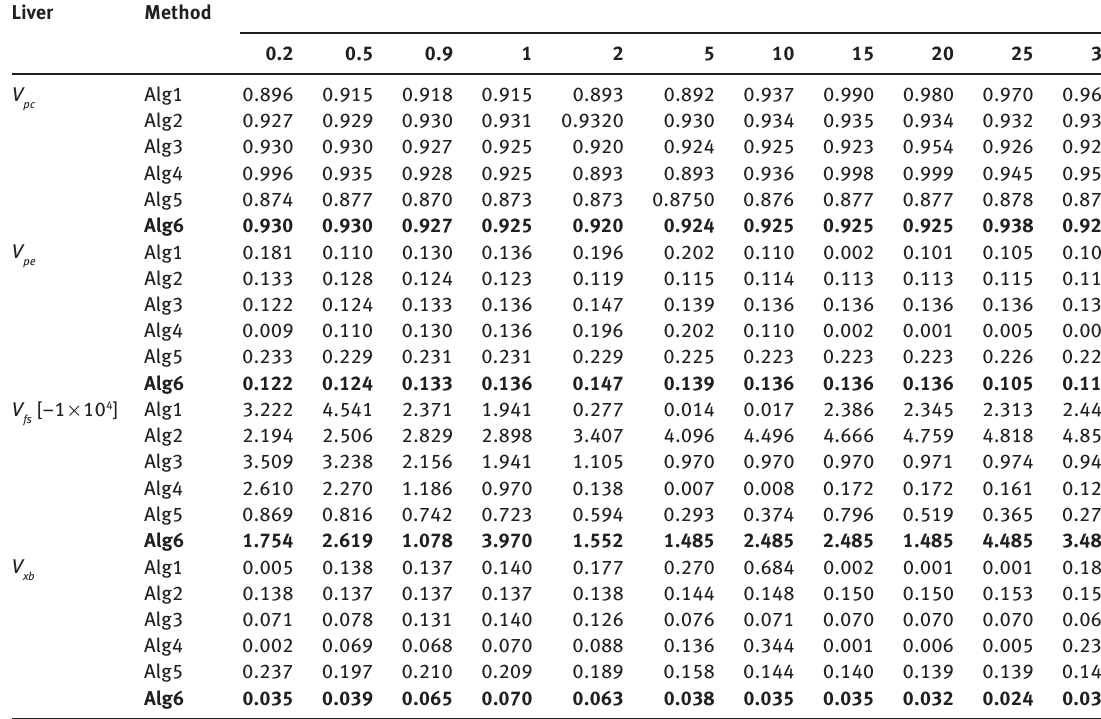
The bold values indicate the results obtained using proposed